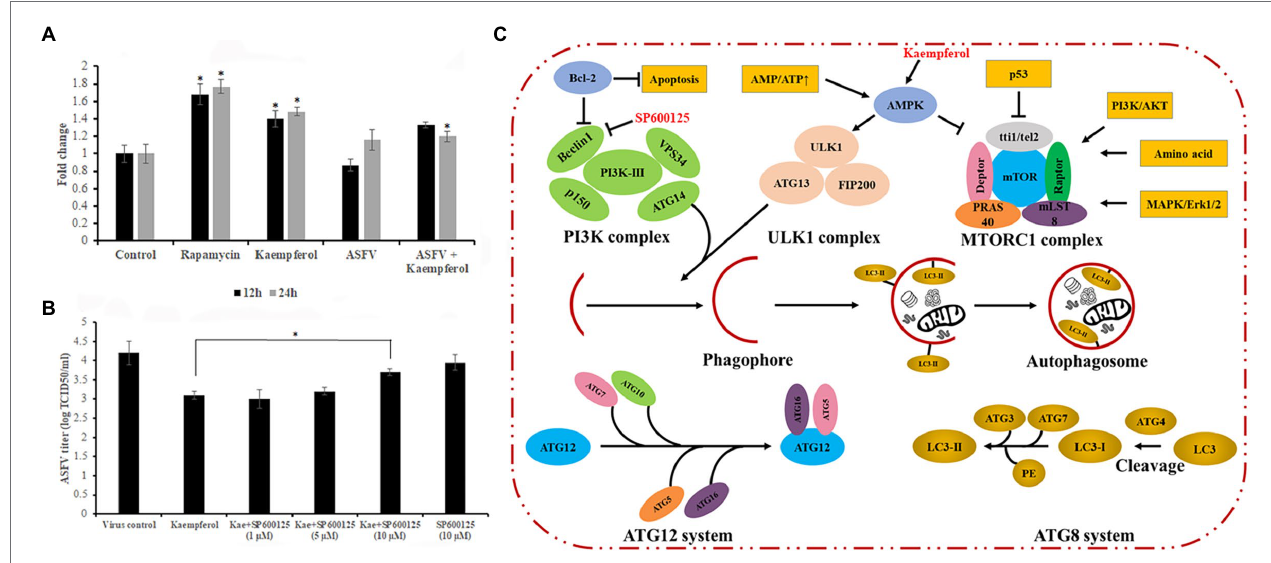
FIGURE 6 | Role of autophagy in the antiviral effect of kaempferol. (A) Effect of kaempferol on the formation of autophagic vacuoles in Vero cells. (B) Reverse effect of autophagy inhibitor SP600125 on the antiviral activity of kaempferol in ASFV-infected Vero cells. (C) Regulation of autophagy signaling pathway. Kaempferol causes AMPK activation, which can lead to autophagy induction through downstream signaling. These signaling pathways eventually result in phagophore formation and subsequent stages involve autophagosome maturation, lysosomal fusion, and finally cargo degradation. The SP600125 inhibitor can prevent Beclin-1 upregulation as part of repressing the JNK-Beclin1 signaling pathway, which can in turn inhibit autophagy induction (Parzych and Klionsky, 2014). Results in (A) and (B) graphs represent the mean (± SD) of three independent experiments ( n = 3). Significant differences compared to control are denoted by * p <